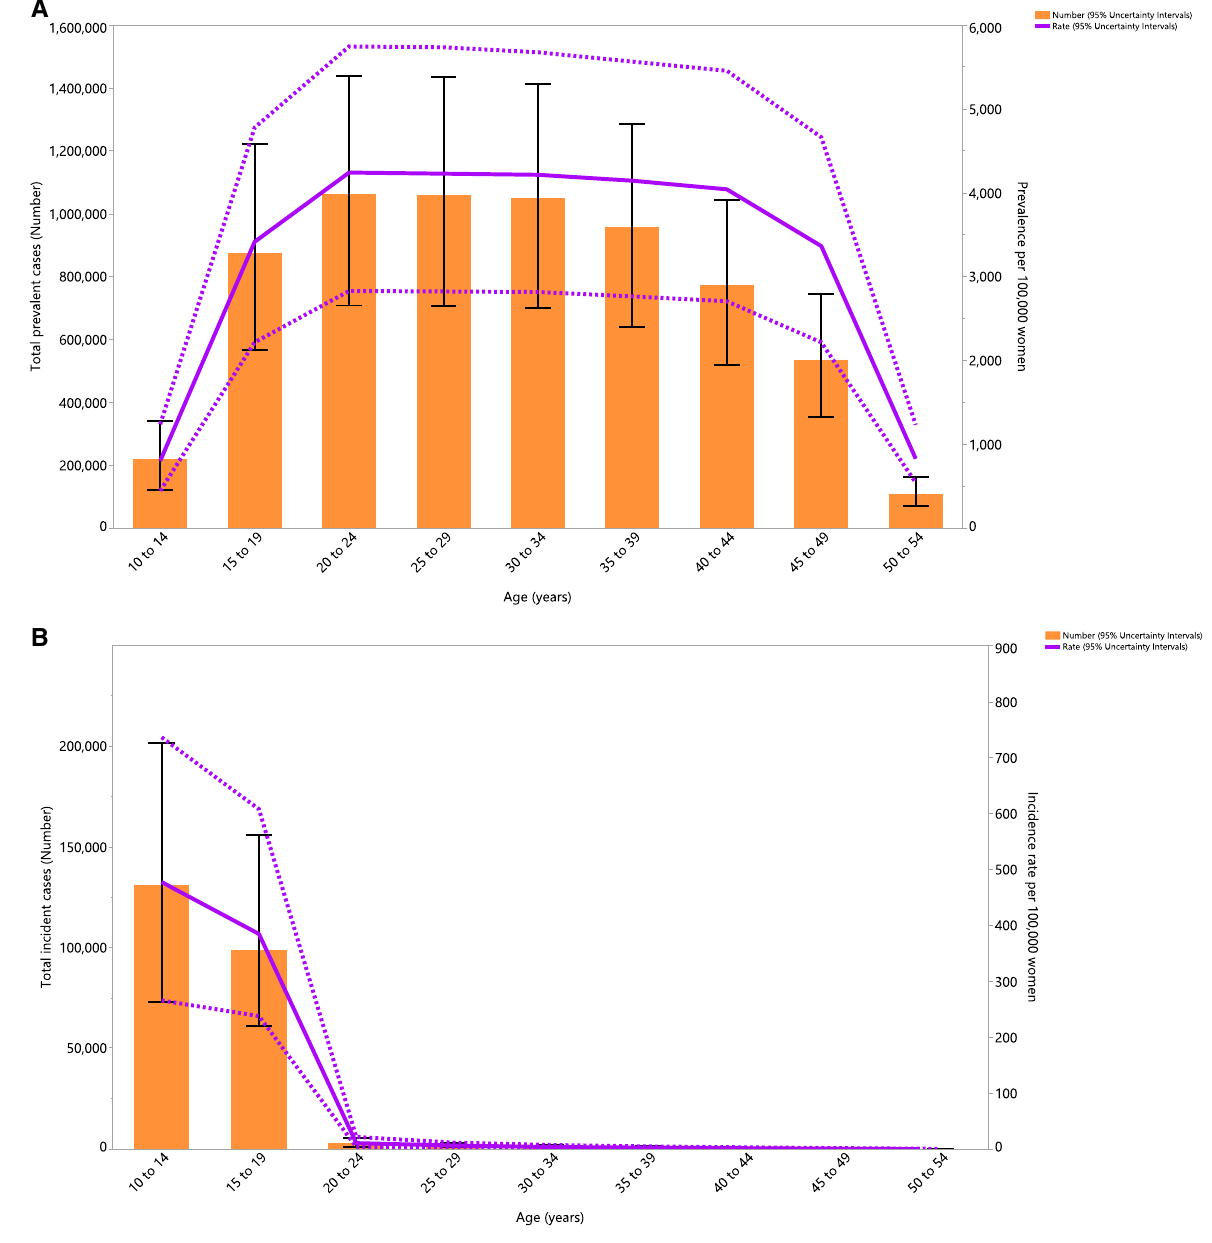
Figure 2. Number of prevalent cases and prevalence ( A ), number of incident cases and incidence rate ( B ), and the number of YLDs and YLD rate ( C ) for polycystic ovary syndrome (per 100,000 population) in the Middle East and North Africa region, by age, in 2019; Dotted lines indicate 95% upper and lower uncertainty intervals, respectively. The black solid vertical lines represent the 95% uncertainty interval for the number of prevalent cases, incident cases, and YLDs. YLD = years lived with disability. (Generated from data available from http:// ghdx. healt hdata. org/ gbd- resul ts-